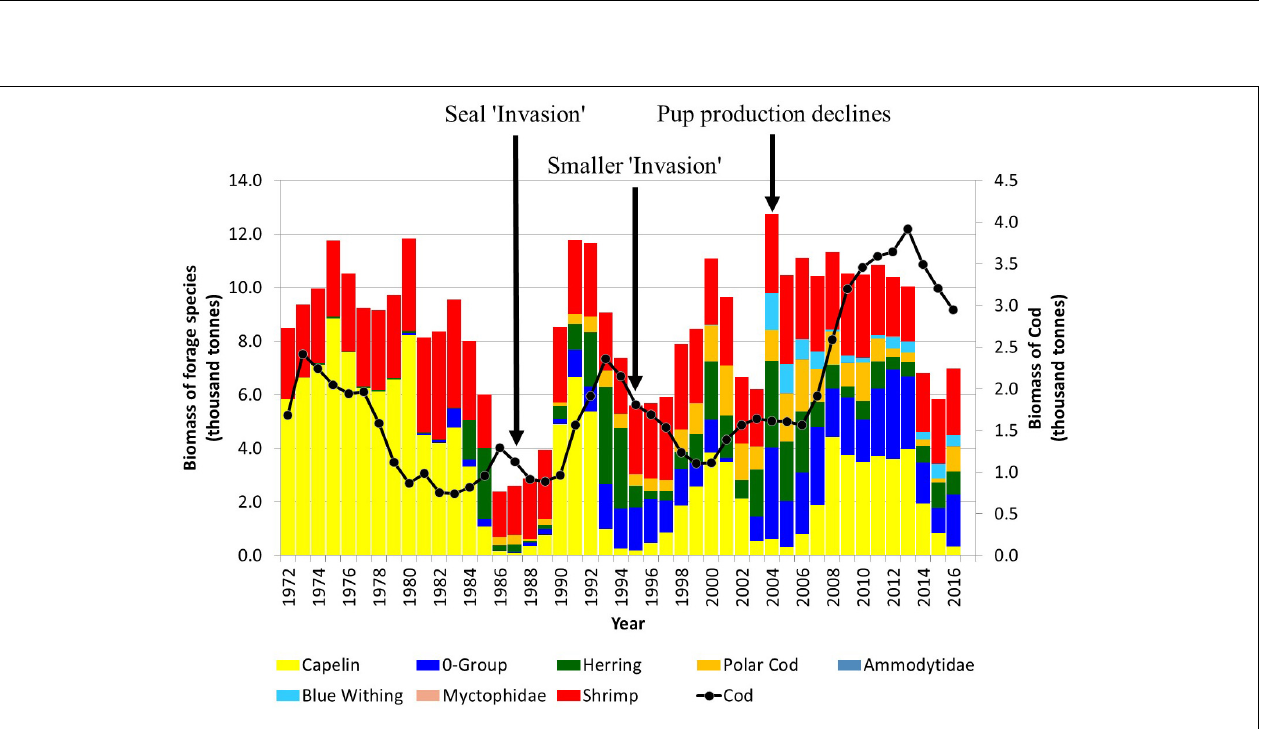
Frontiers in Marine Science |